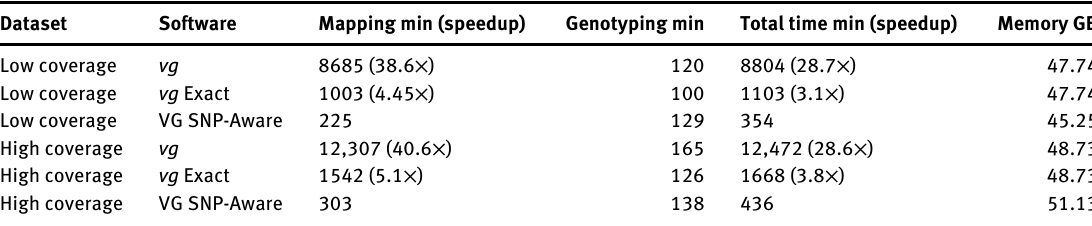
Table 2: Time and memory comparison for reads alignment and genotyping for various tools. Dataset